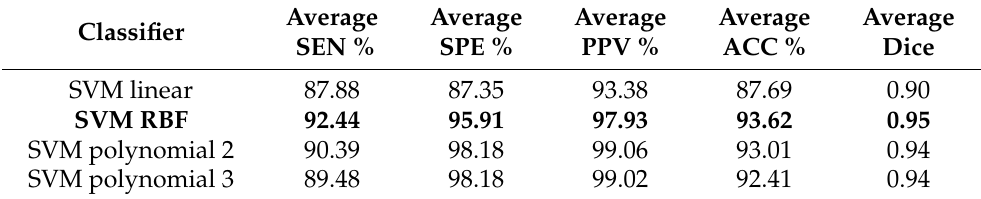
Table 5. Classification results of the SVM